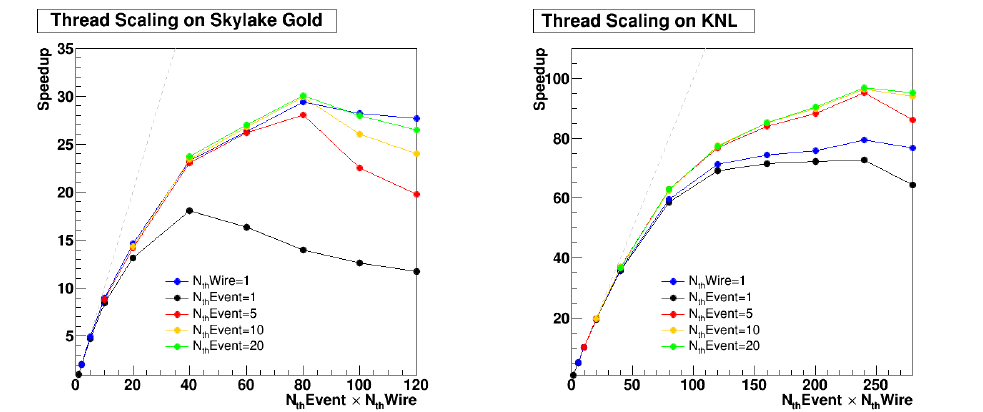
Figure 3. Multi-threading speedups with respect to serial execution on SKL (left) and KNL (right). Each curve indicates a di ff erent configuration in terms of number of threads, where each configuration has a fixed number of threads per event or per